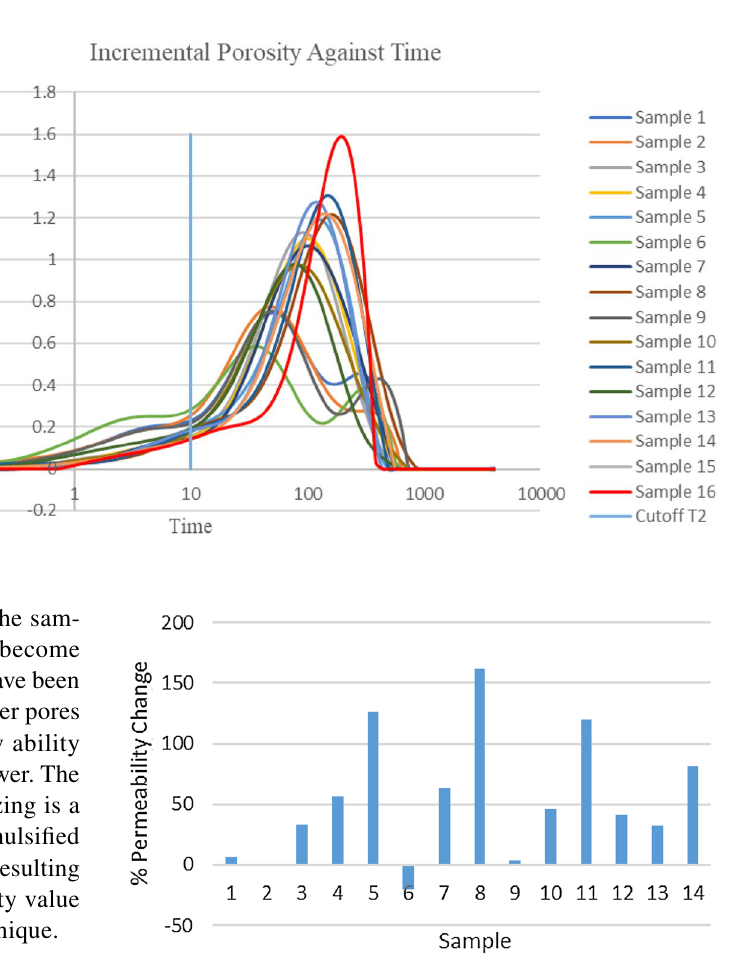
Fig. 4 Permeability change after